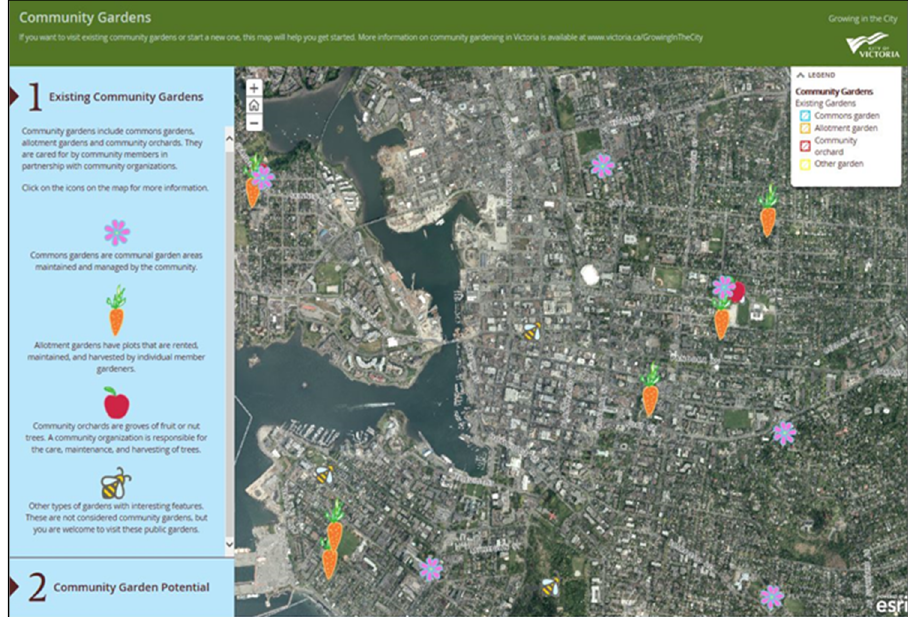
Figure 2. Existing Community Gardens on